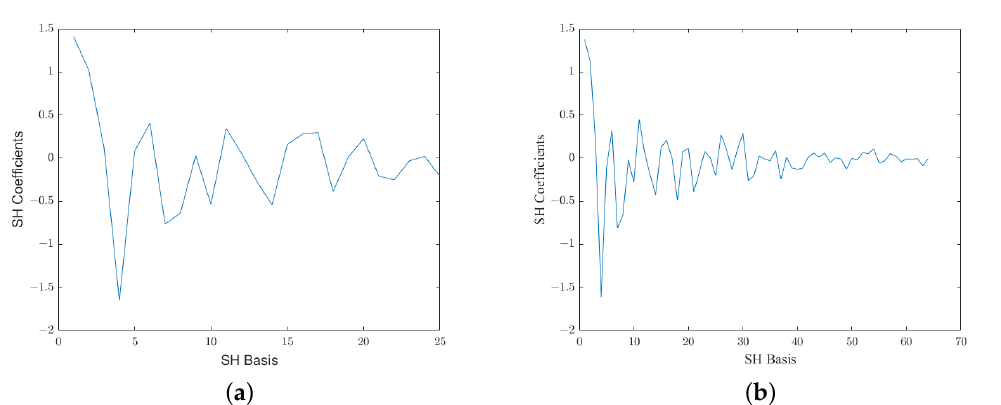
Figure 10. Coefficients of the SH basis: ( a ) L = 4 and ( b ) L =